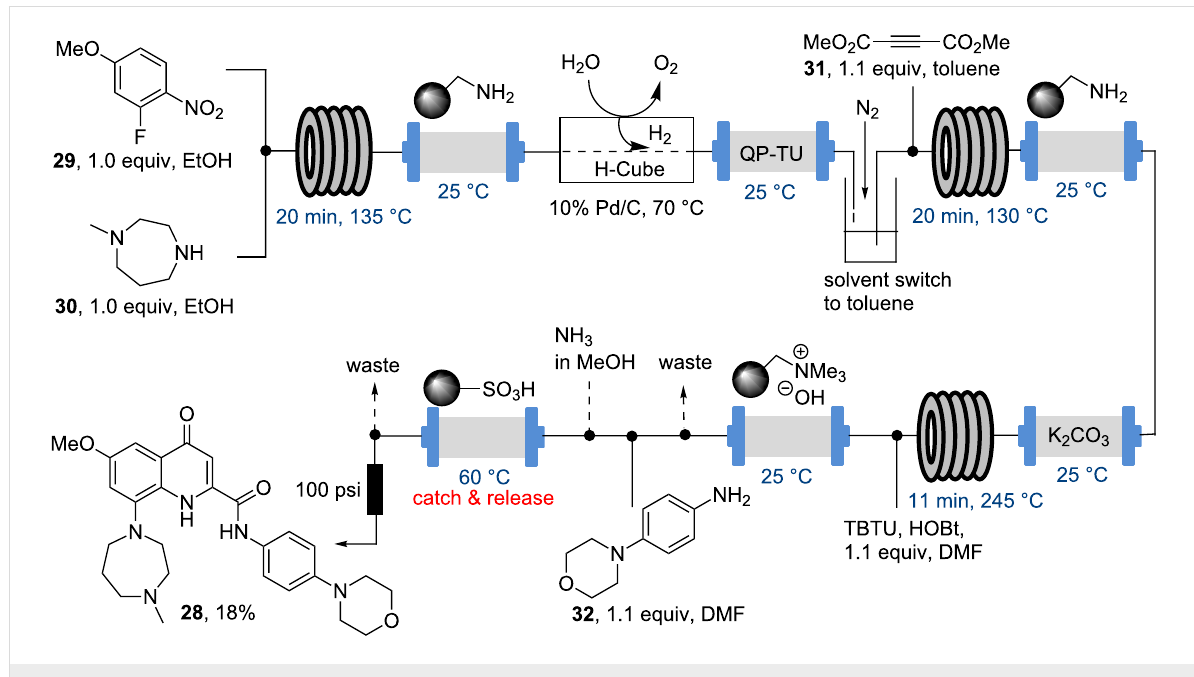
Scheme 5: Flow synthesis of the potent 5HT1B antagonist 28